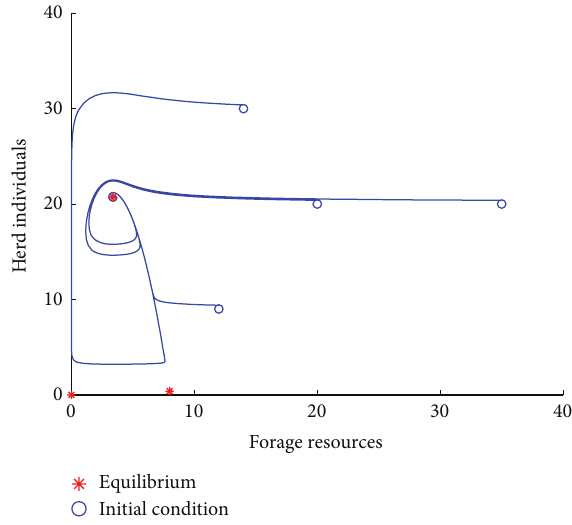
Figure 6: Phase portrait of the herd’s animals and forage resources of System (1) when 𝑟 = 500 kgDM/ha, 𝑒 = 0.05/ day, 𝑎 = 0.013/ ha, 𝐾 = 8 – 30 kgDM/ha, 𝑞 = 0.4/ day, and 𝛾 = 0.07/ day. Illustration of the stability of the unique coexisting equilibrium 𝐸 2 = (𝑅 ∗ ,𝐻 ∗ ) for four initial conditions.